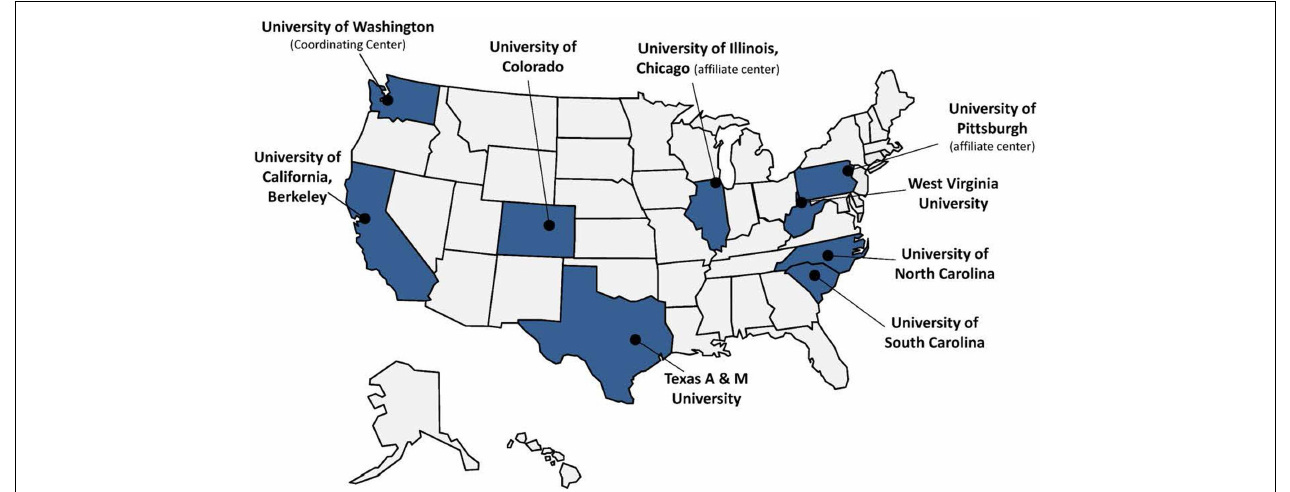
FIGURE 1 | CDC HealthyAging Research Network (HAN) member centers and affiliates (FY 2009-2014)